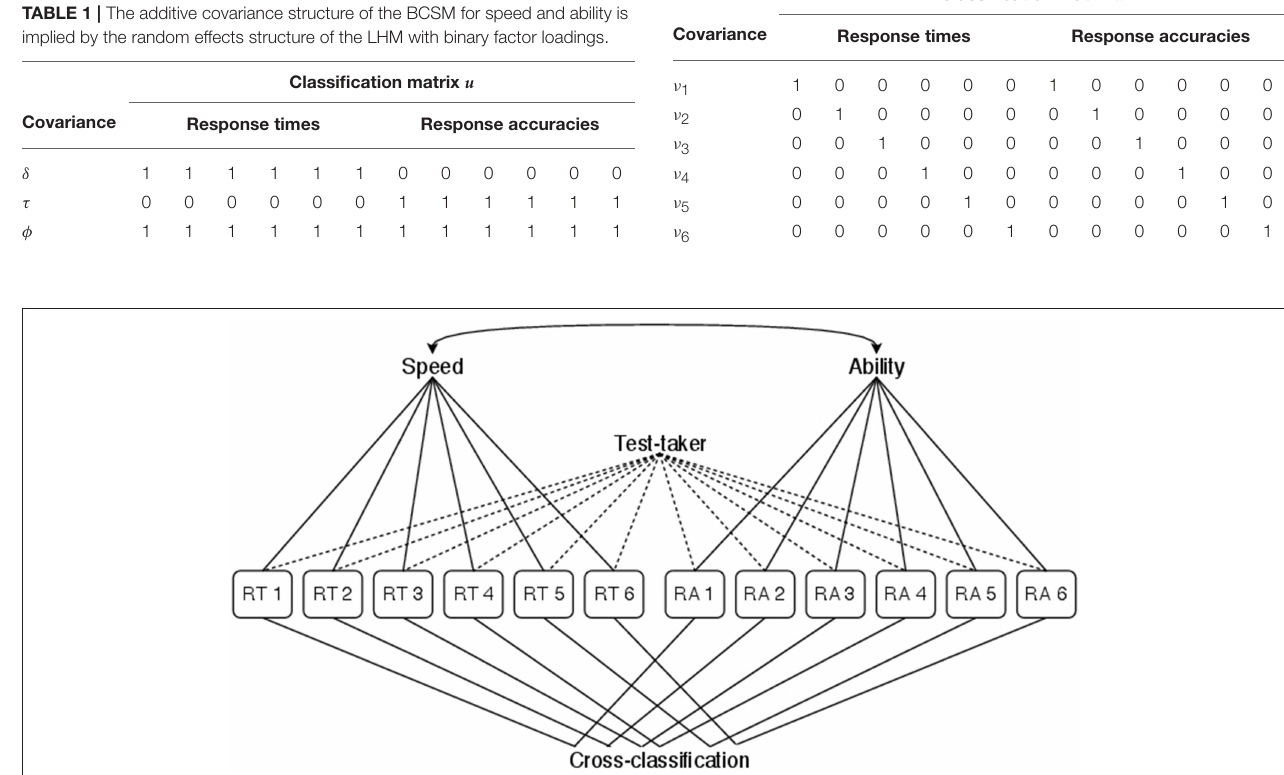
FIGURE 1 | Classification diagram for the variable speed-accuracy trade-off model. The classification implied by the LHM is extended by grouping components item-wise. This allows the group level speed-accuracy trade-off to vary between items.